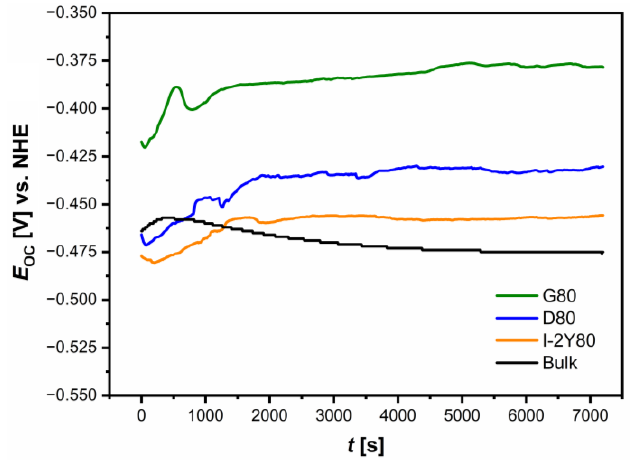
Figure 7. Dependence of open circuit potential on immersion time for the CpTi G2 cellular lattice with TPMS architecture of G80, D80, I-2Y80, and the bulk electrode in 0.1 M KOH solution saturated with O 2 at 25 °C.